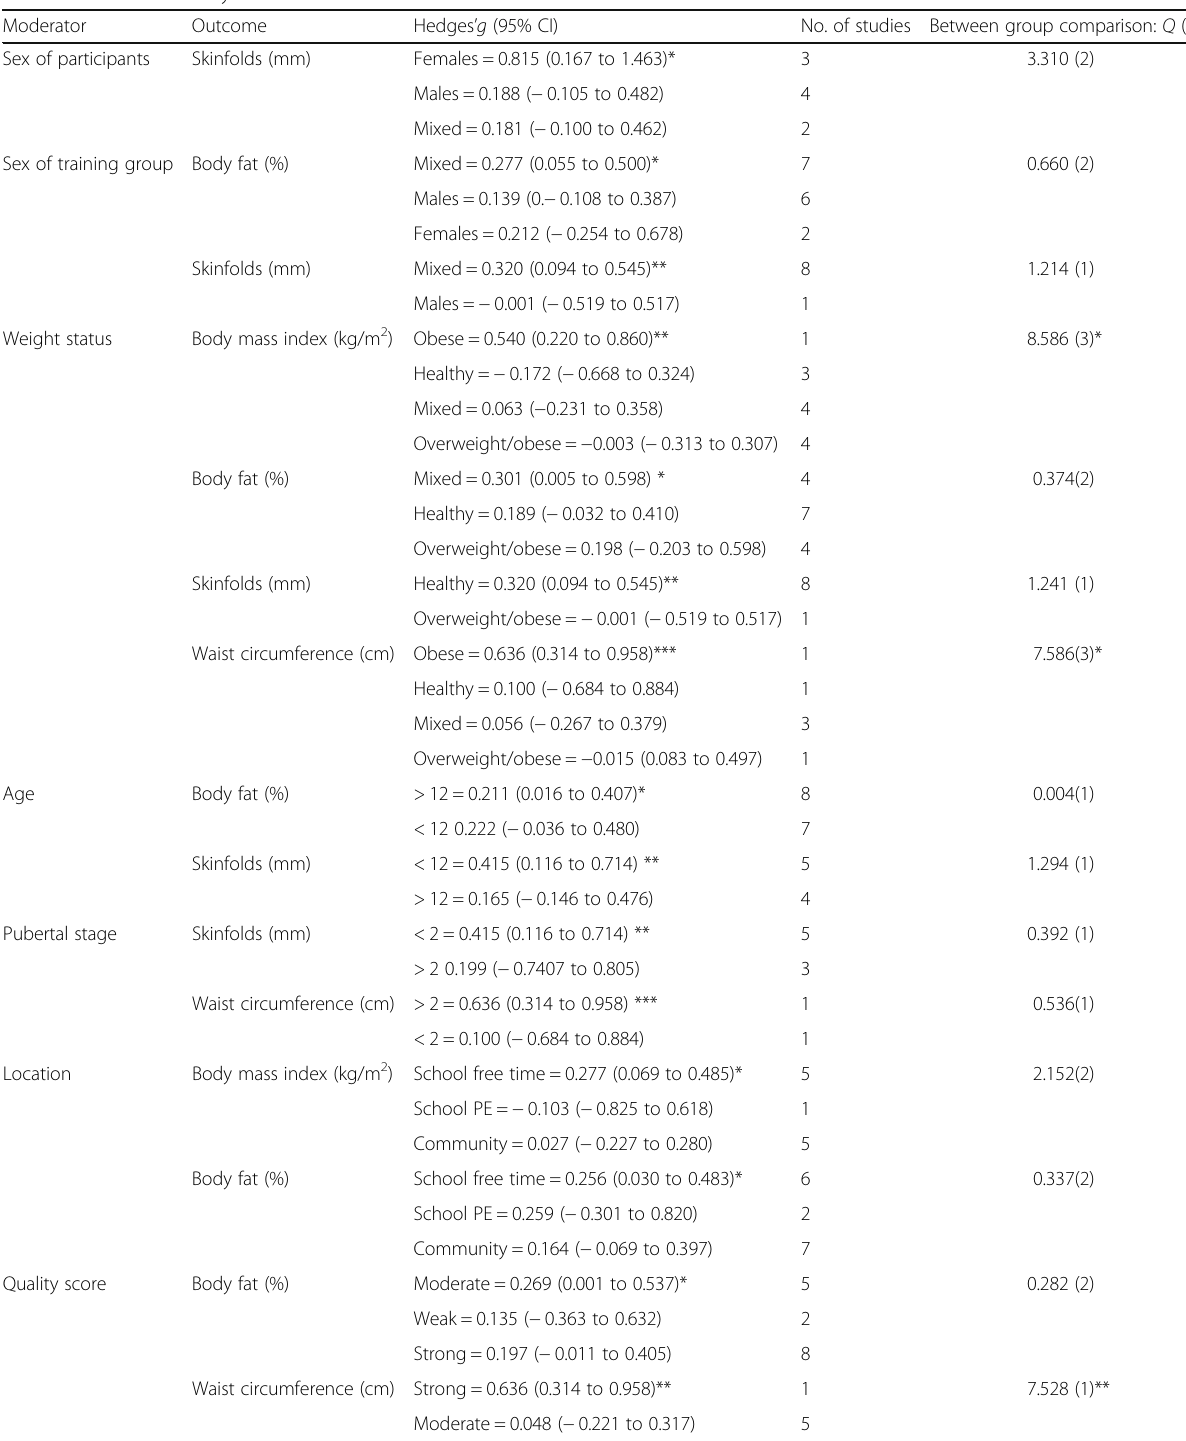
Table 3 Moderator